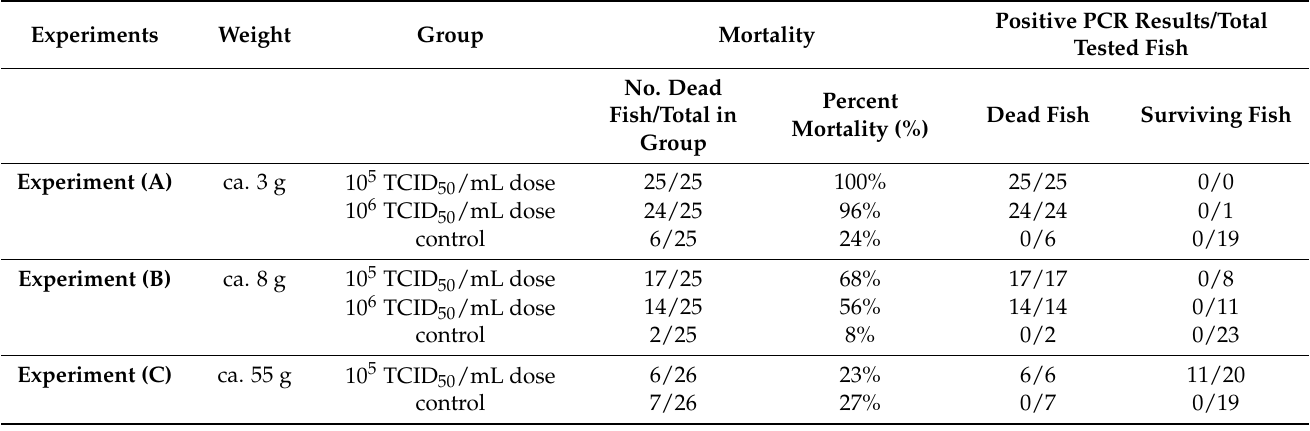
Table 1. Percent cumulative mortality in Experiments (A), (B), and (C) at the two virus dosages used, and the number of positive PCR results from the dead or the surviving